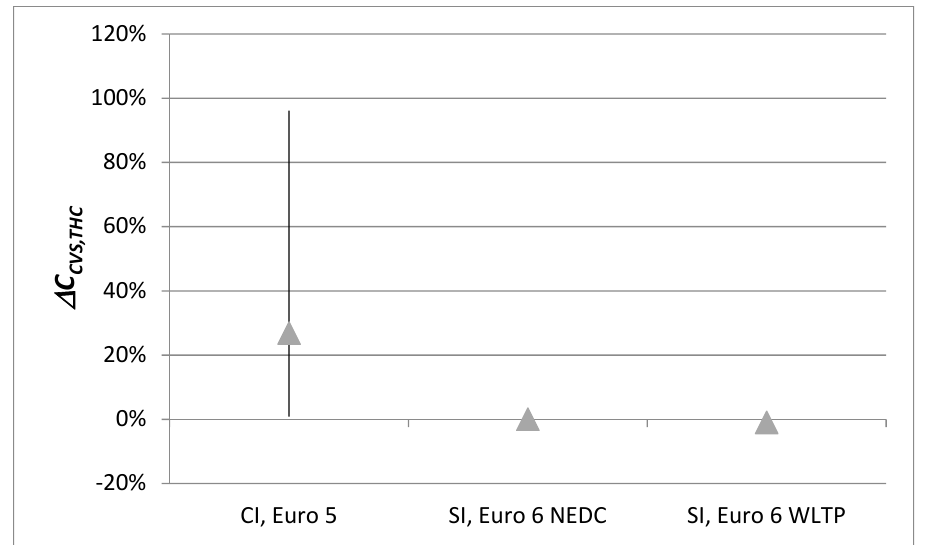
Figure 13. Relative percentage difference in determining the C CVS,corr concentration of the pollutant as calculated from dilution ratio DR (19) and dilution factor DF (3) for NO x .